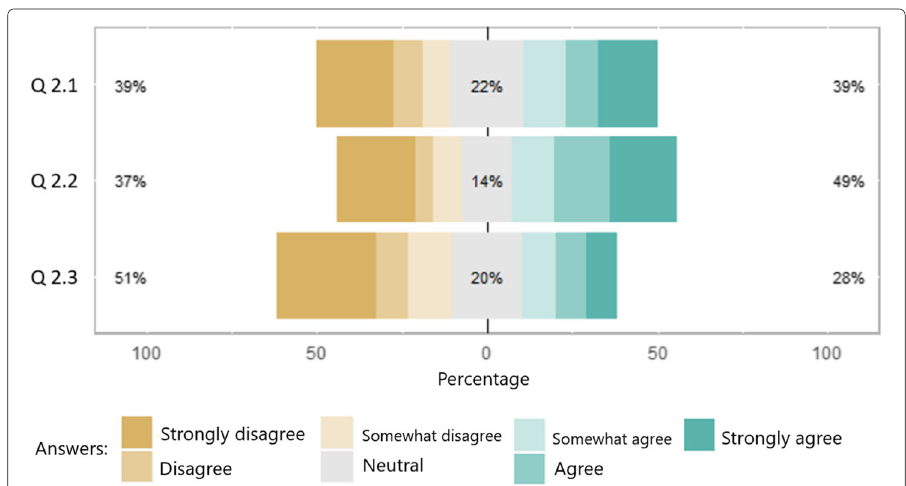
Fig. 6 Change in online study behavior. Degree of agreement on the change in online study behavior (source: (Ferreira et al. 2019))